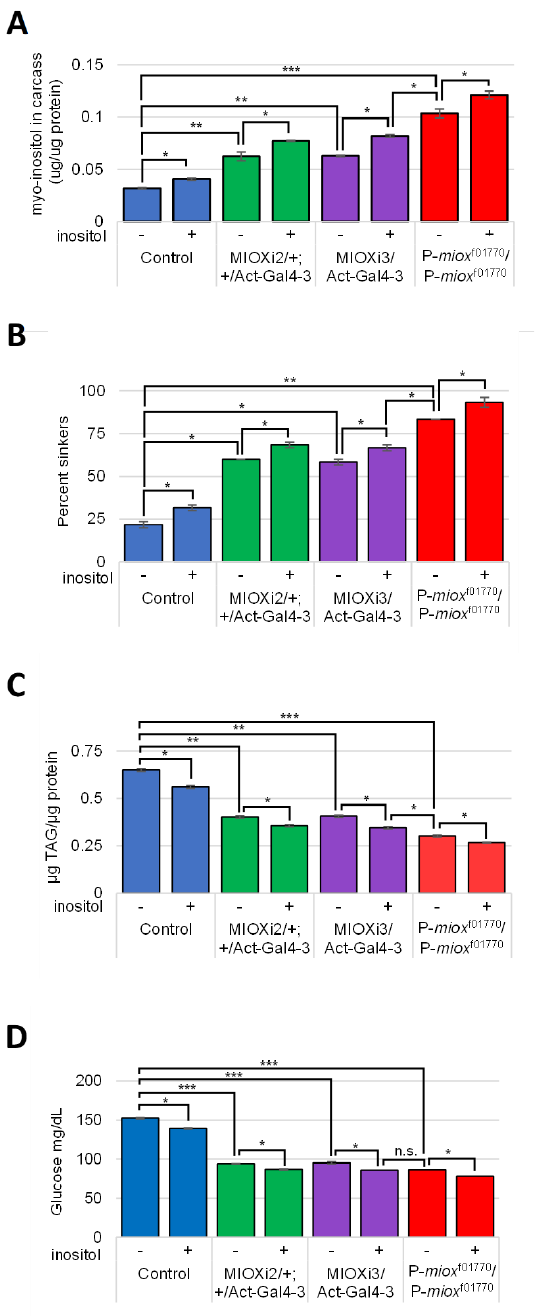
Figure 4. Reduced myo- inositol catabolism increases myo- inositol levels but decreases larval obesity and hemolymph glucose. Larvae grown on standard rich food with myo- inositol supplementation as indicated. ( A ) Larval carcasses assayed for myo- inositol; values indicated are normalized to total protein. N = 5 per condition per trial. ( B ) Buoyancy assay; the percentage of larvae that sink are displayed. N = 20 per condition per trial. ( C ) TAG assay; values indicated are normalized to total protein. N = 6 per condition per trial. ( D ) Glucose (mg/dL) assay of hemolymph. N = 5 per condition per trial. Mean ± SE of three independent trials of each experiment are represented. * p < 0.05; ** p < 0.005; *** p < 0.0001 as indicated, determined by two-tailed t -test. Control strains ActGal4- 3/TbGFP and CyOGFP/+: ActGal4-3/+ were indistinguishable from the wild-type control Canton-S results shown for all four